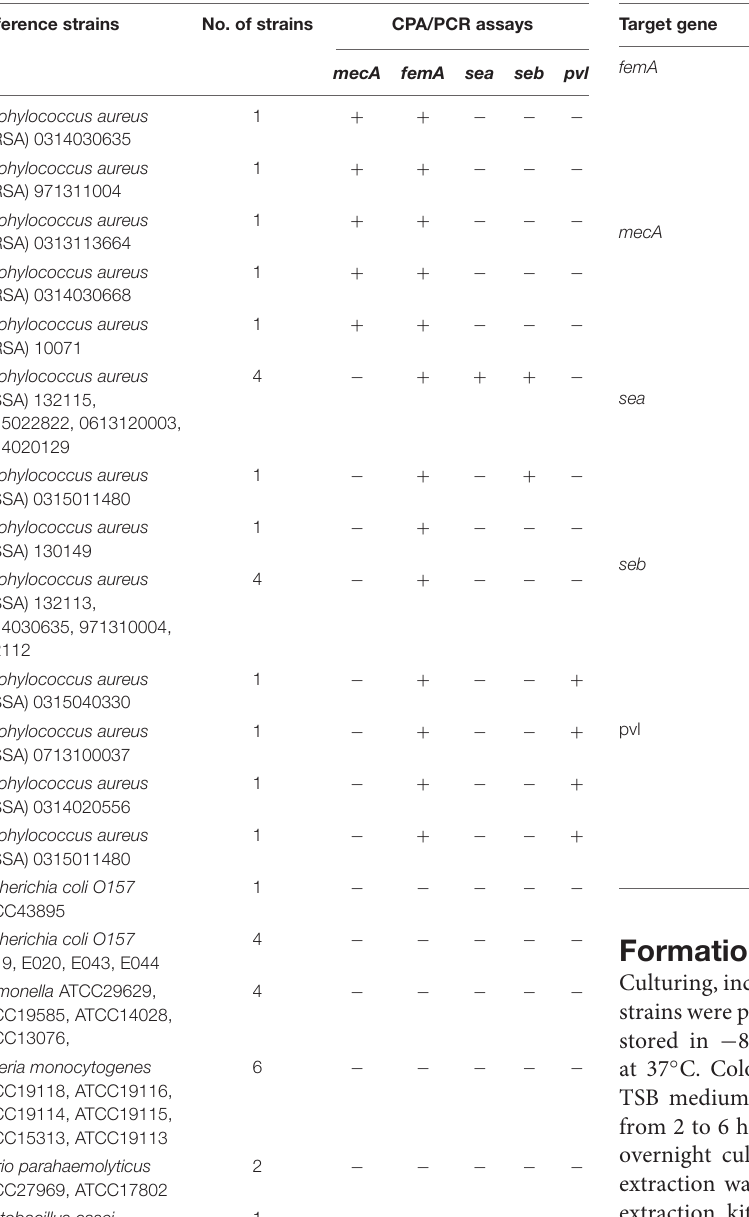
TABLE 1 | Reference strains used and the results of CPA assays. TABLE 2 | Primer sequence of